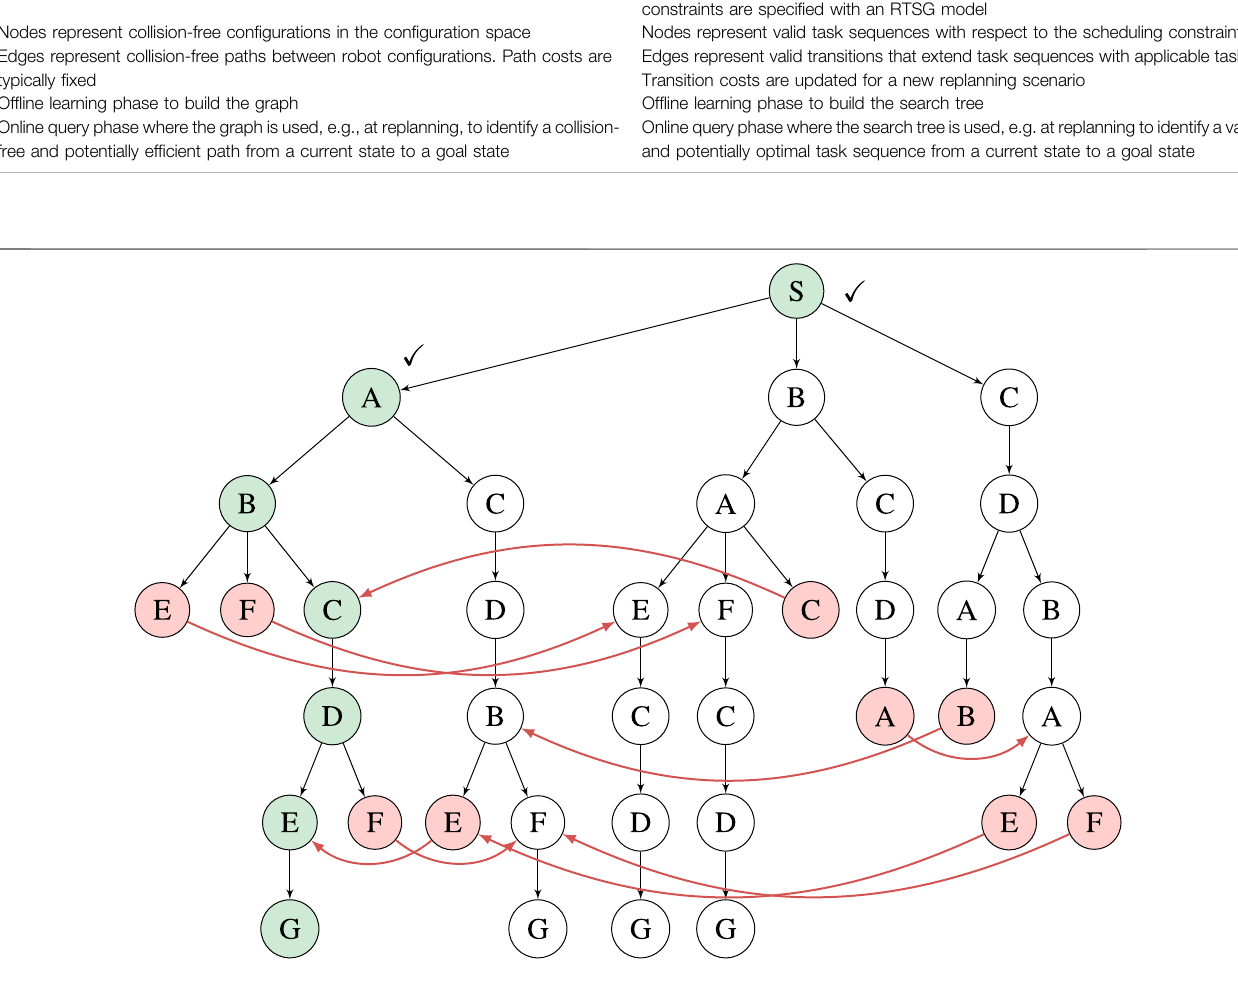
Frontiers in Robotics and AI |